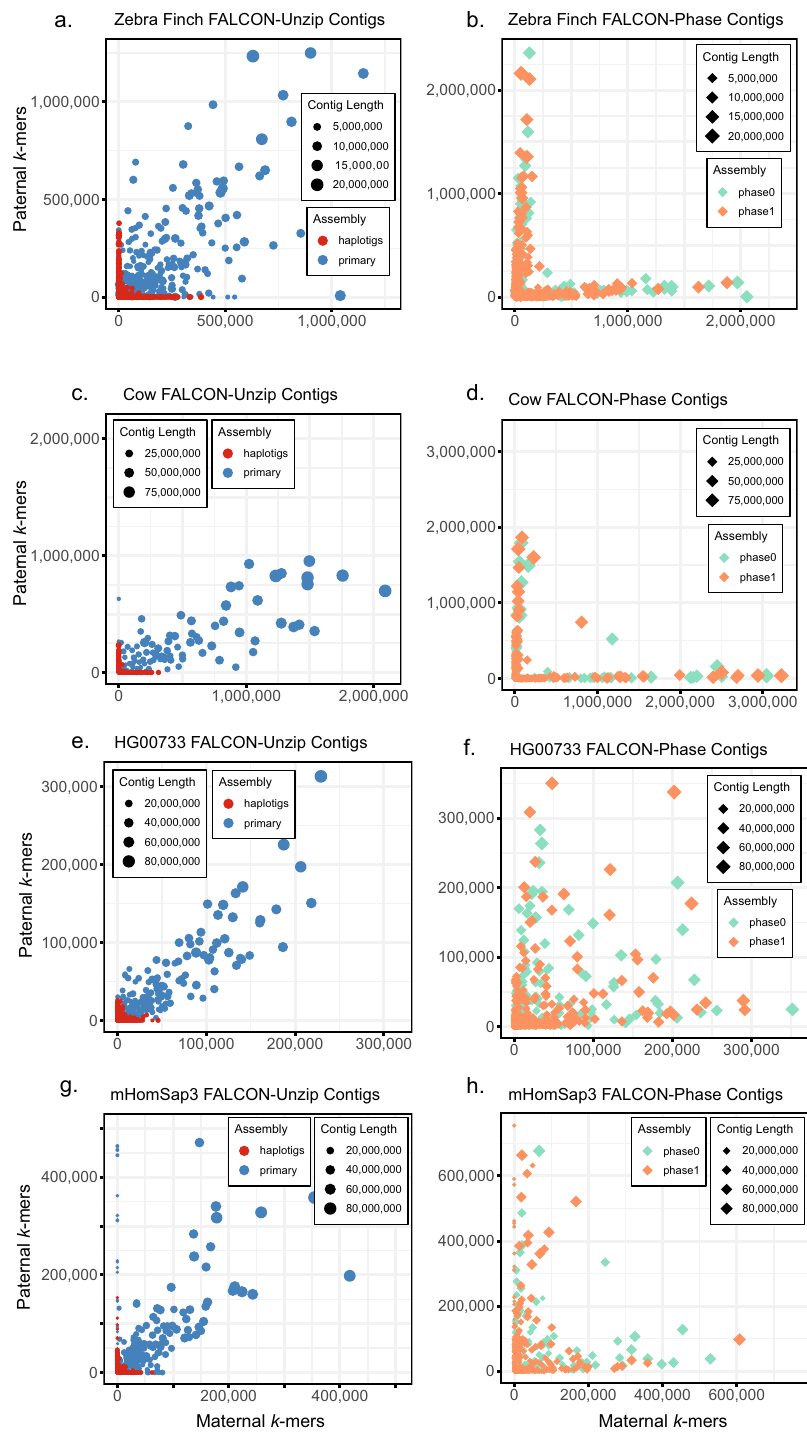
Fig. 2 Phasing accuracy of contigs before (left) and after applying FALCON-Phase (right) to the contigs. Parent-speci fi c k -mer count from mother is on the x -axis and father on the y -axis. Contig size is indicated by size of the data point and well-phased contigs lie along the axes. Unphased primary contigs (blue) are large but contain a mixture of k -mer markers from mother and father. Haplotigs are mostly phased but shorter in length. After phasing by FALCON-Phase, phase 0 and phase 1 contigs are of similar length to the FALCON-Unzip primary contigs and have less mixing of parental markers within contigs. a Zebra fi nch contigs before phasing; b zebra fi nch contigs after phasing; c cow contigs before phasing; d cow contigs after phasing; e HG00733 contigs before phasing; f HG00733 contigs after phasing; g mHomSap4 contigs before phasing; h mHomSap3 contigs after